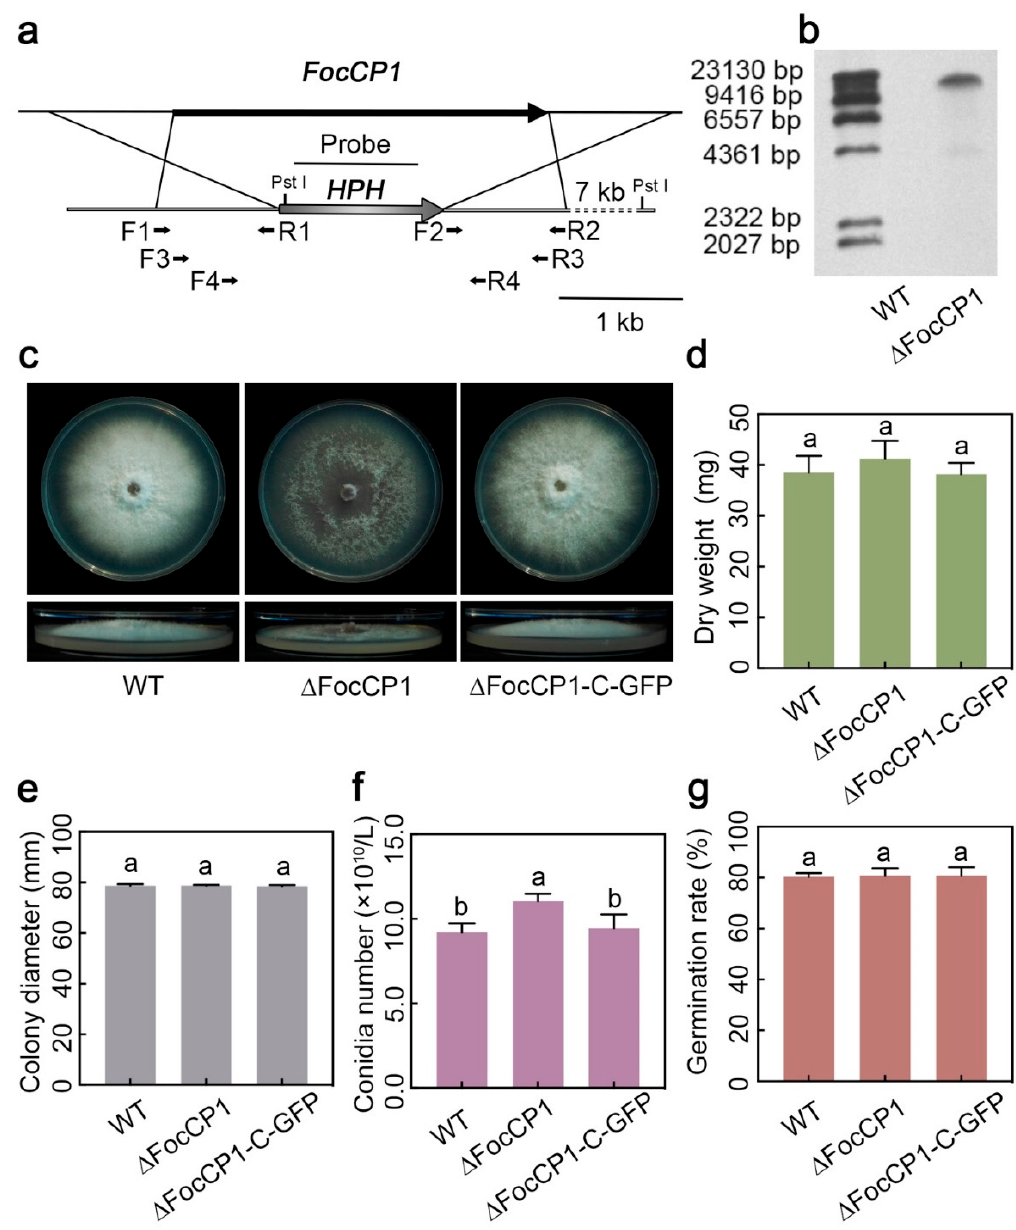
Figure 3. Characterization and vegetative growth of the ∆ FocCP1 mutant strain and its complementary strain ∆ FocCP1-C-GFP. ( a ) Schematic strategy used for generation of the targeted disruption strain ∆ FocCP1; hygromycin-resistance cassette ( HPH ) fragments used as the probes for hybridization are indicated. ( b ) Southern blotting of the targeted disruption strain ∆ FocCP1. ( c ) Colony morphologies of wild type (WT), ∆ FocCP1, and ∆ FocCP1-C-GFP on potato dextrose agar (PDA) plates. Photos were taken 6 days after incubation. ( d ) Dry weight of WT, ∆ FocCP1, and ∆ FocCP1-C-GFP. Hyphae were collected from 5-day cultures of ∆ FocCP1 and ∆ FocCP1-C-GFP strains grown in potato dextrose broth PDB. ( e ) Colony diameter ( f ) conidia production and ( g ) conidial germination of the WT, ∆ FocCP1, and ∆ FocCP1-C-GFP strains. Conidia were collected from 5-day cultures of each strain grown for 5 days in MLB. Conidia production was counted with a haemocytometer. Conidia were incubated in extract peptone dextrose (YEPD) broth for 12 h and the germination rate was determined by randomly collecting 100 conidia. Data presented in ( d – g ) are means ± SDs from three independent experiments. The letters above the histograms indicate significant di ff erences at p < 0.05 between the WT and the ∆ FocCP1 and ∆ FocCP1-C-GFP strains (Student’s t -test). 2.4. The FocCP1 Protein is Carried by Vacuoles and Predominantly Functions in the Apoplast